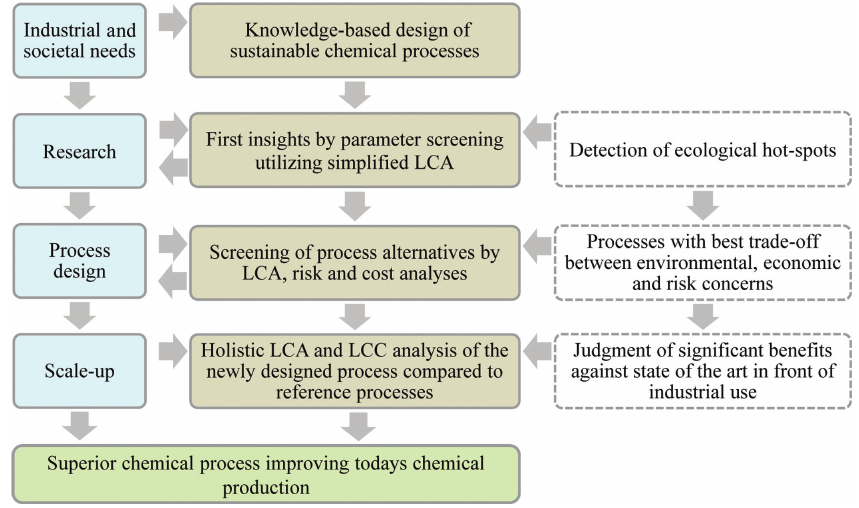
Figure 1 Evaluation approach within CoPIRIDE according to Kralisch and colleagues